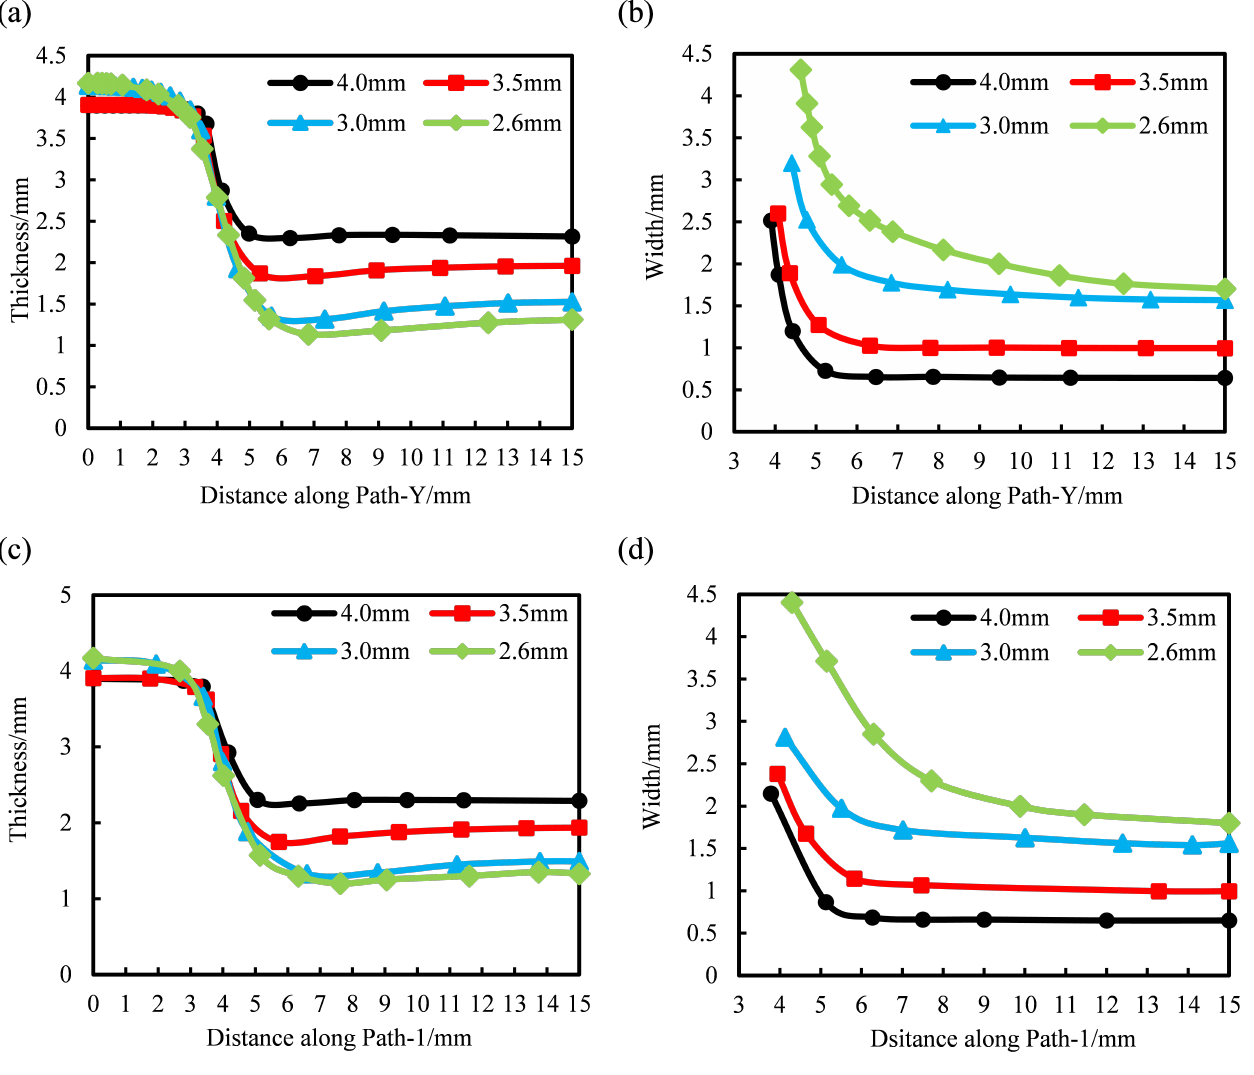
Figure 20. Variation of thickness and width of 90° bar along Path-Y and diagonal bar along Path-1. ( a ) Thickness of 90° bar along Path-Y, ( b ) width of 90° bar along Path-Y, ( c ) thickness of diagonal bar along Path-1, ( d ) width of diagonal bar along